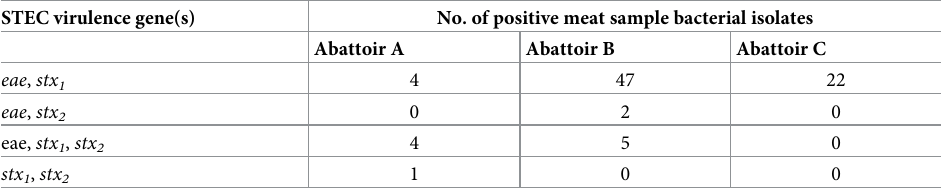
Table 3. Summary of detected STEC virulence genes from the meat sample bacterial isolates from informal and commercial abattoirs. STEC virulence